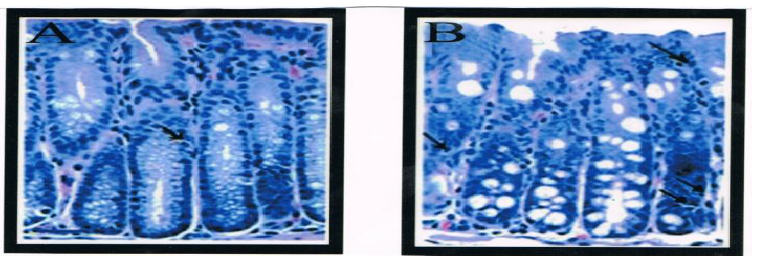
Figure – 1 – sections of intestine at 5days after Ecoli oral dosing arrows in panels (A) sparse IEL and lamina propria PMNs in control tissue the colon of Ecoli -infected rat showed increases in the numbers of intestinal